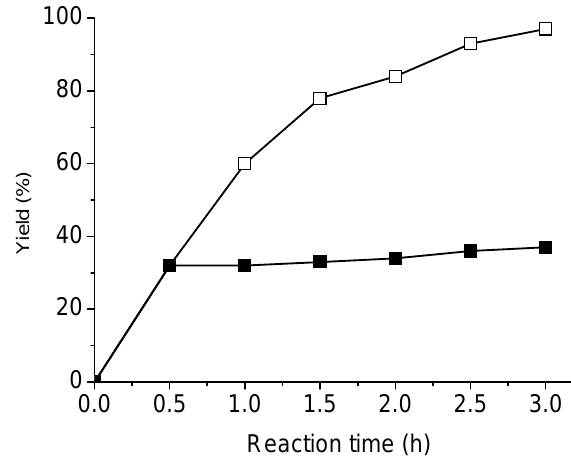
Figure 2. Plot of yield versus time with hot-filtration for 0.5 h of reaction at 50 °C ( ■ )